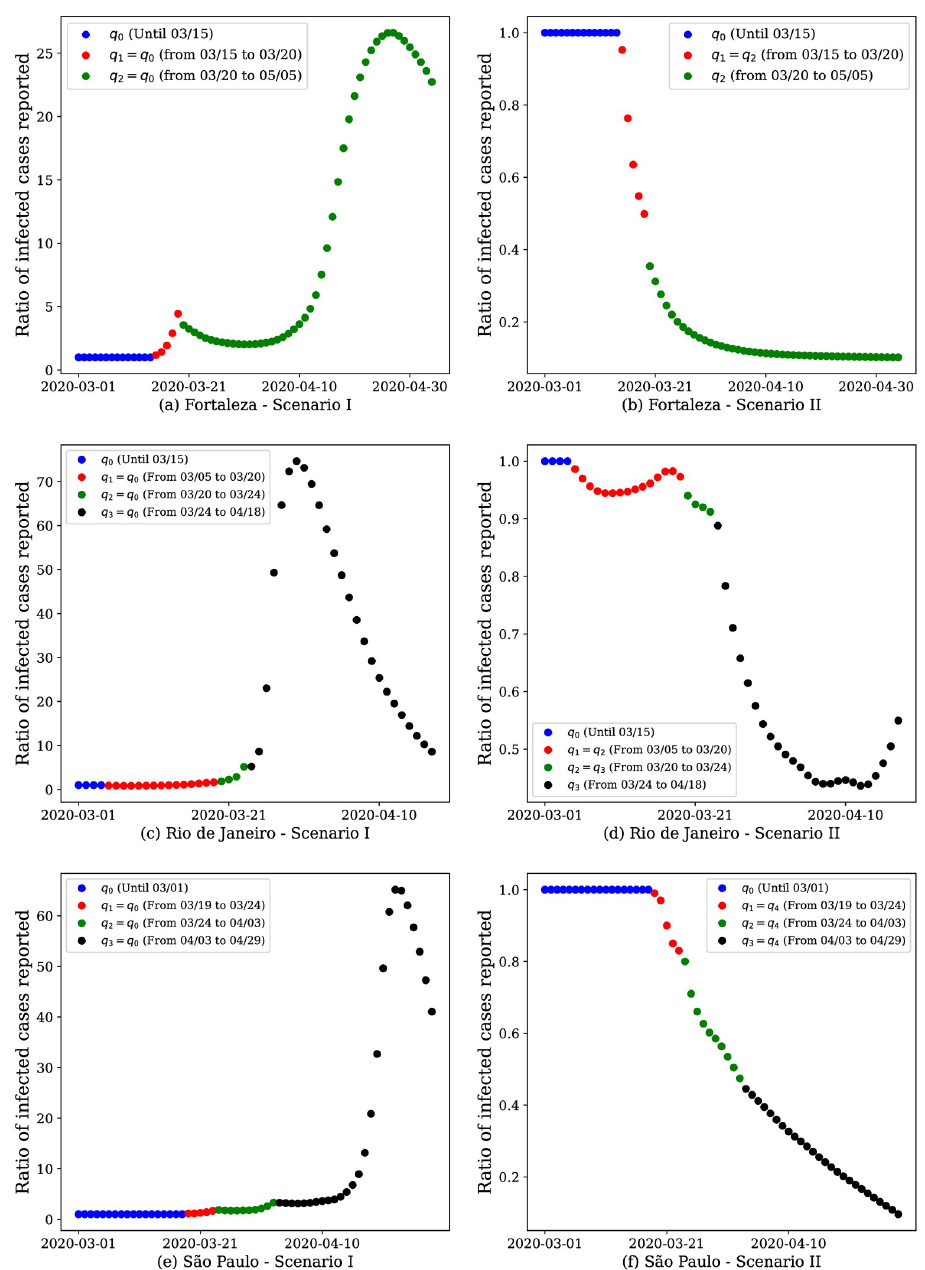
Fig 7. Results of hypothetical scenarios for coarse-grained data. The model response when simulating two hypothetical scenarios: I) the population and neither the government prioritized measures to restrict mobility and II) after the first case notified in the city, the government decreed the closure of trade. Here we analyze the ratio between the number of infected individuals in the analyzed scenarios and the actual number of infected individuals to observe the curve trend over